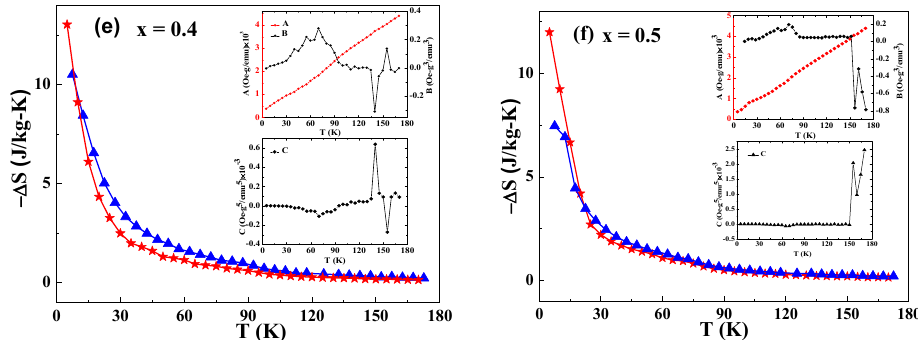
Figure 10. ( a – f ): Temperature dependence of magnetic entropy change ( − ∆ S ) of GECMO series calculated using Landau theory and Maxwell’s relation. Insets show the variation in Landau coefficients.